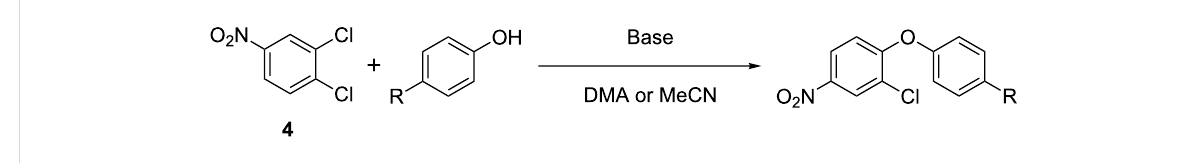
Scheme 1: Illustration of the model reaction used to compare the enabling technologies of microwave and microreactor synthesis.